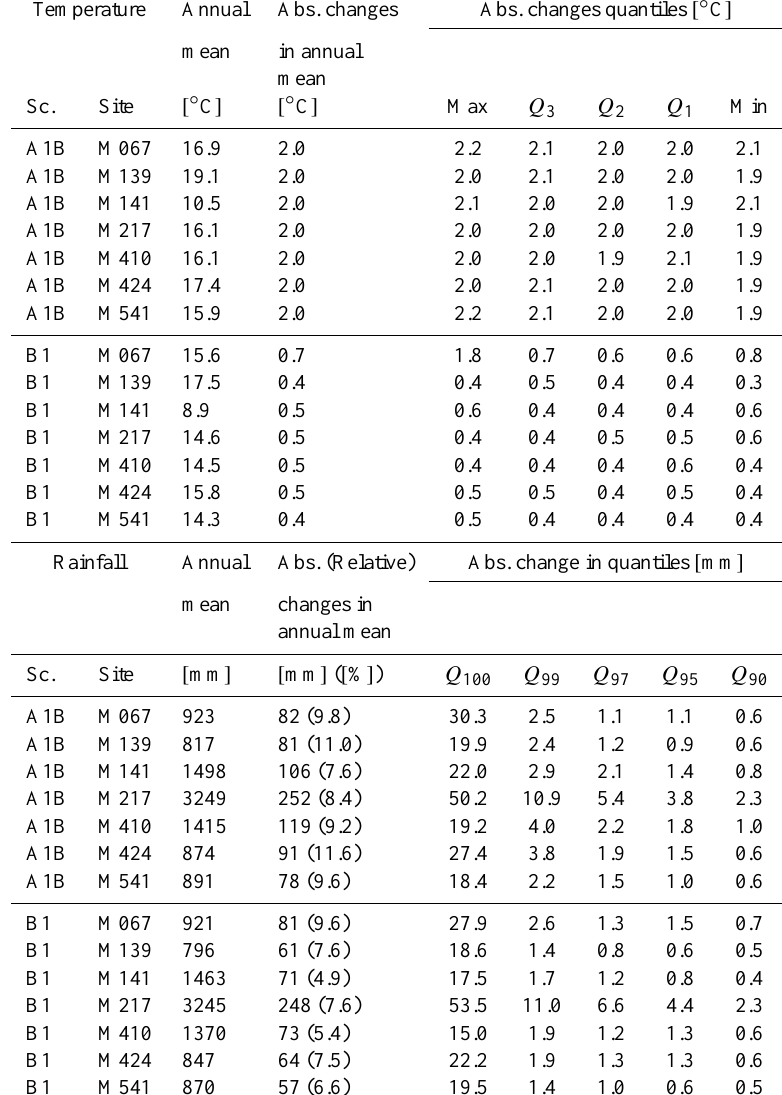
Table 5. Impact indicators for temperature and rainfall downscaled output series for 2045–2065, scenarios A1B and B1. Temperature Annual Abs. changes Abs. changes quantiles [ ◦ C